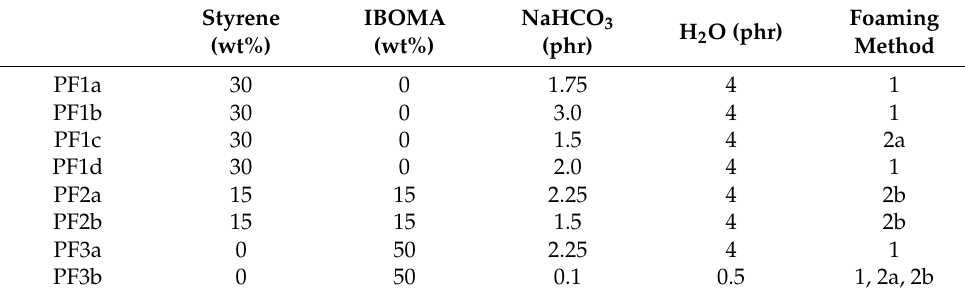
Table 1. Formulation of polymeric